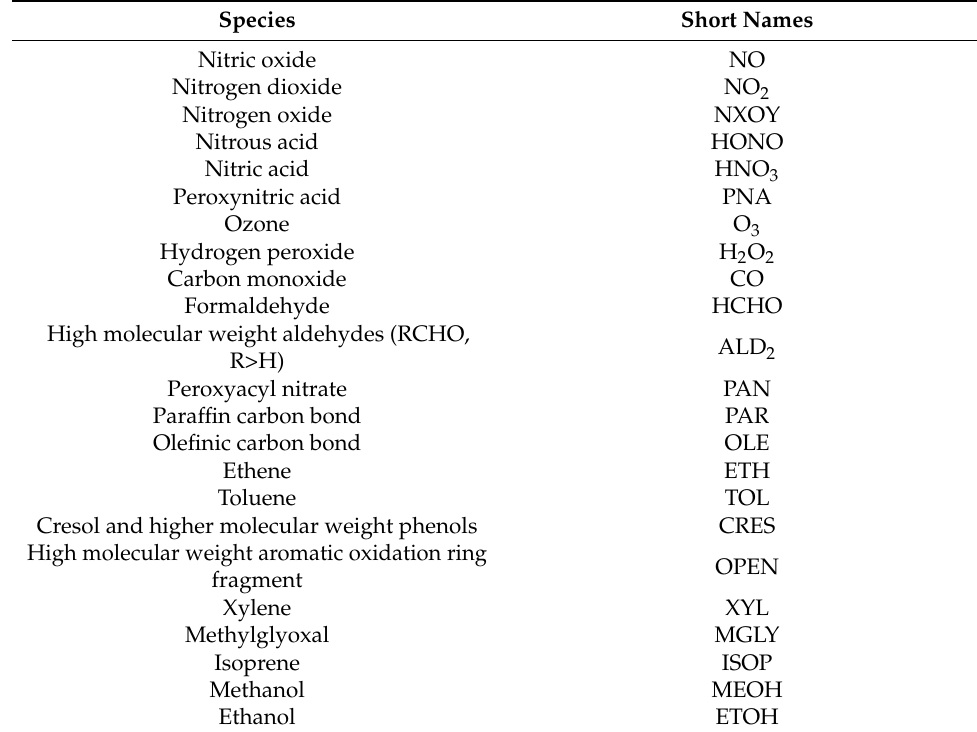
Table A1. The list of chemical substances and their short names.